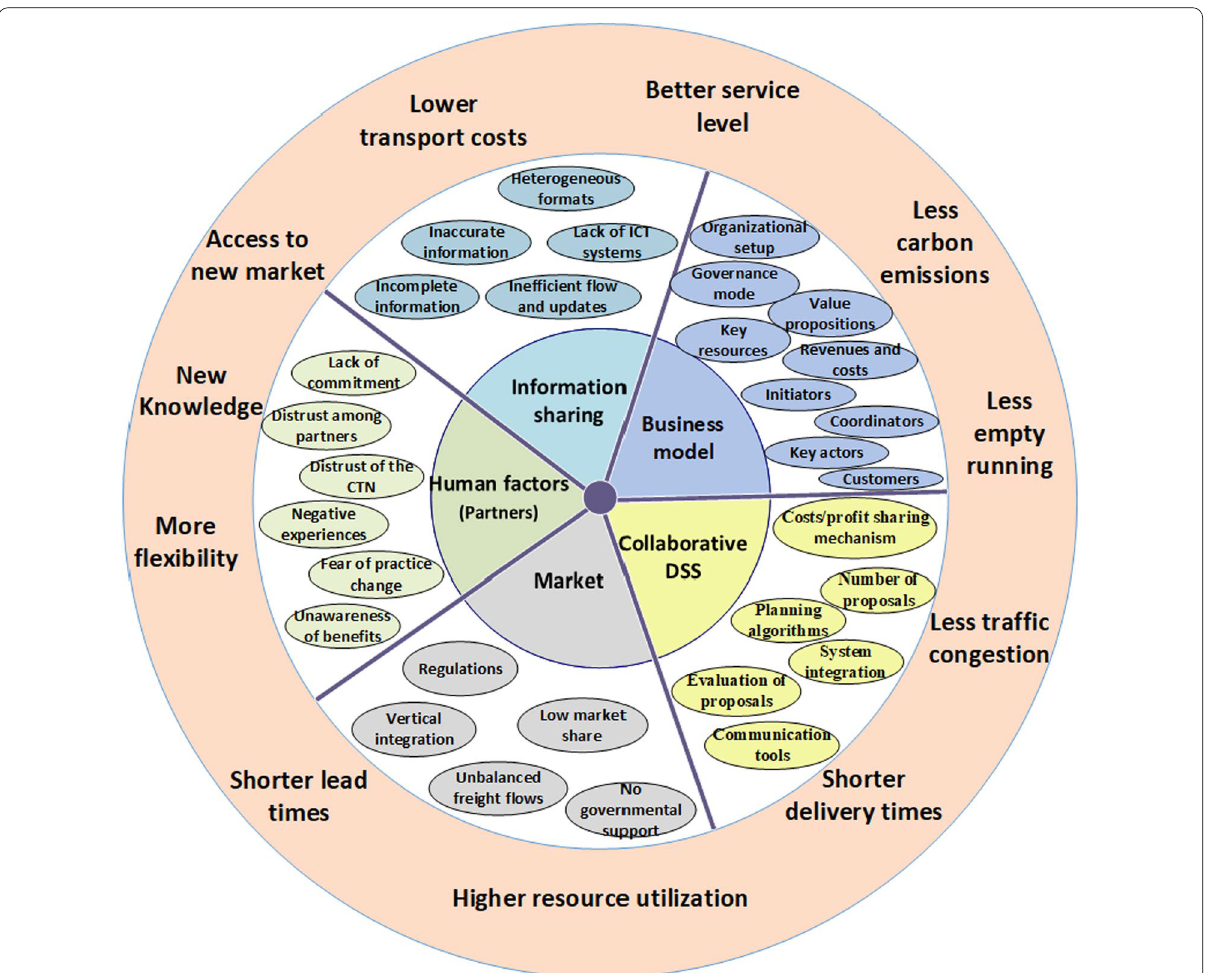
Fig. 4 Main elements of collaboration, barriers to collaboration success (black box), and potential benefits (ordered from inner to outer circles). See “Appendix 1” for references of the identified barriers and “Appendix 2” for references of potential benefits